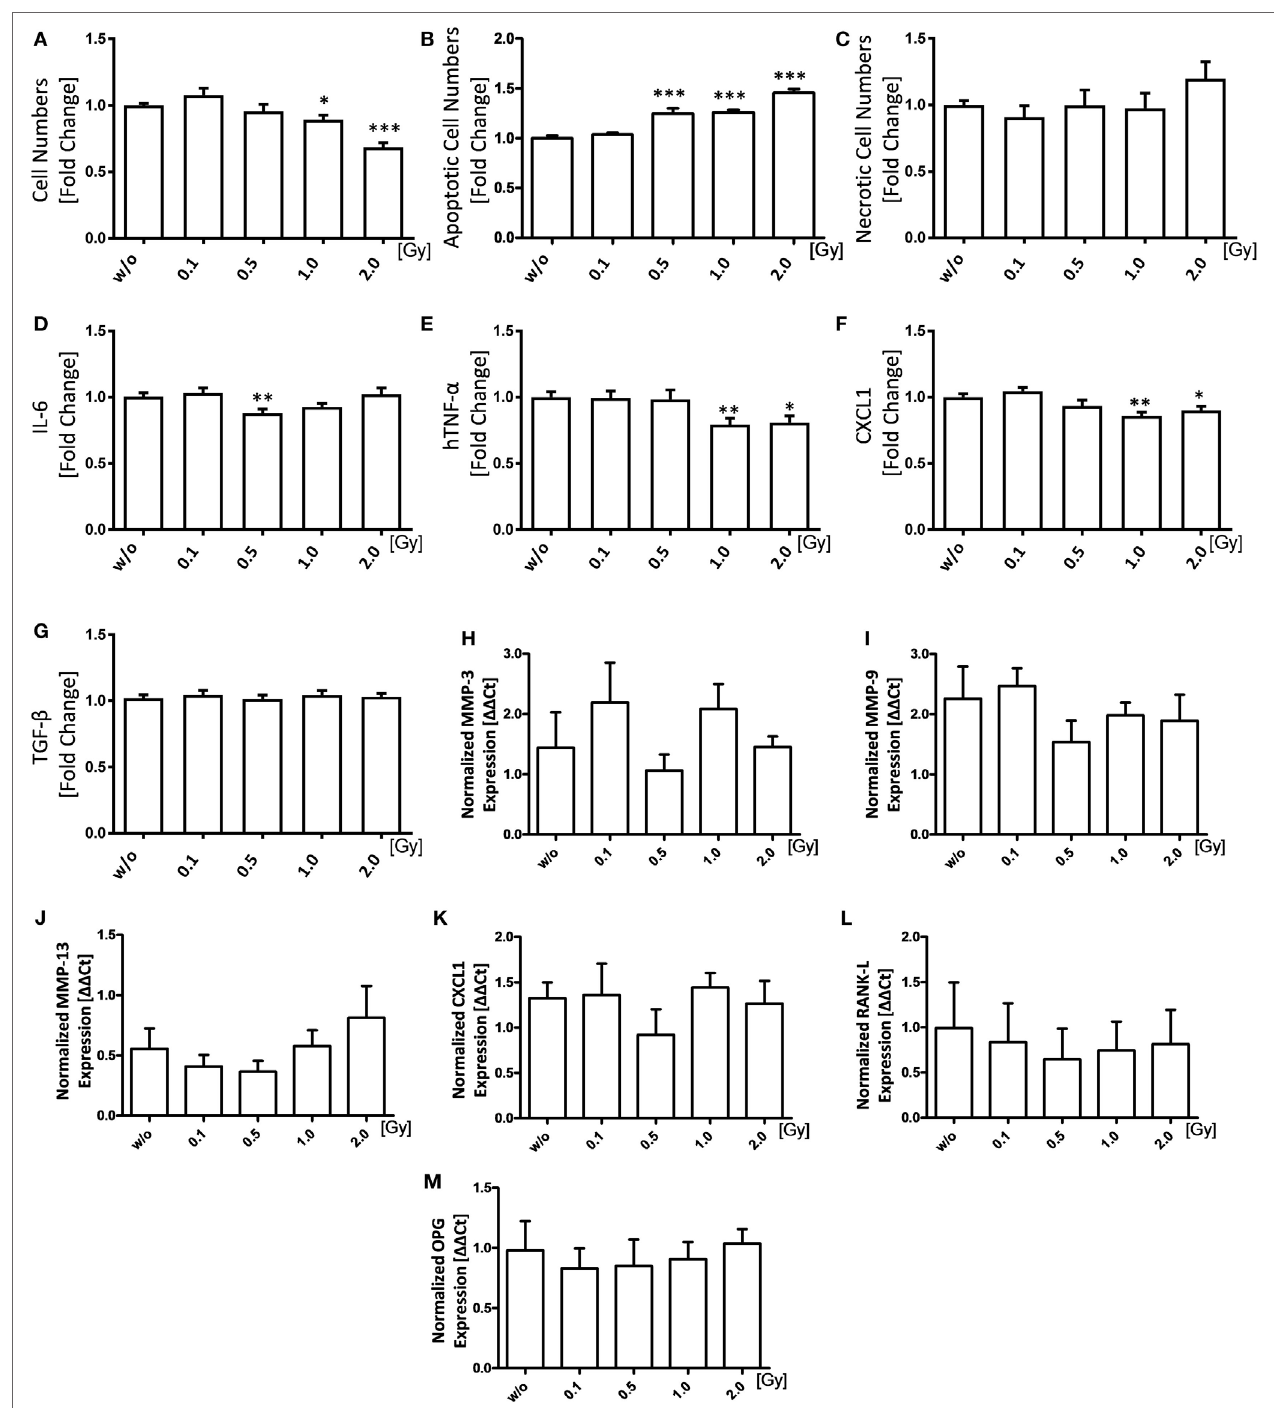
FigUre 1 | Low-dose irradiation induces apoptosis of fibroblast-like synoviocytes (FLS) and slightly impacts on the inflammatory FLS phenotype. Inflammatory FLS obtained from h TNF- α tg mice were analyzed 96 h after irradiation with various doses of X-rays. Cell numbers (a) of living cells were counted using a Neubauer chamber and cell death was determined via flow cytometry analysis after staining with AxV-FITC/PI. Vital cells were defined as AxV − /PI − , apoptotic cells as AxV + /PI − (B) , and necrotic ones as AxV + /PI + (c) . Quantification of secreted IL-6 (D) , hTNF- α (e) , CXCL1 (F) , and TGF- β (g) was performed 96 h after irradiation in supernatants of FLS cultures via enzyme-linked immunosorbent assays. Total RNA levels were isolated using phenol–chloroform extraction. Gene expression was analyzed using SYBR Green quantitative PCR analysis (h–M) . Depicted is joint data obtained of five h TNF- α tg-FLS cell lines, examined in four independent experiments, each performed at least in triplicates. Data are presented as mean ± SEM, tested for normal distribution, and analyzed by students t test (a–g) or two-tailed Mann–Whitney U test (h–M) in comparison to mock-treated (w/o) controls at 96 h after irradiation (* p < 0.05, ** p < 0.01, and *** p < 0.001).